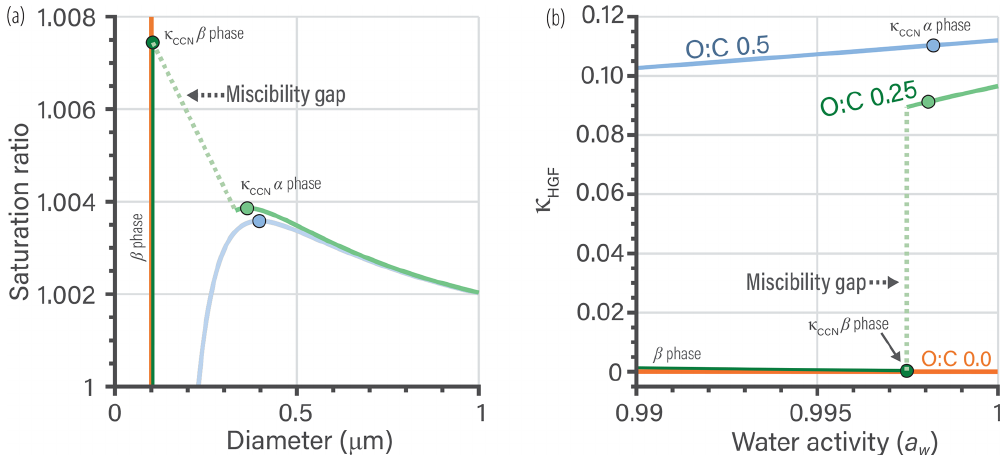
Figure 9. Three different organics with O : C of 0.5 (blue), 0.25 (green), and 0.0 (orange) with constant M org of 200gmol − 1 at T = 298 . 15K. (a) CCN growth curves for the three water–organic mixtures. (b) κ HGF versus water activity curves for the water–organic mixtures. The circles represent the extracted κ CCN values, based on the maximum in saturation ratio vs. particle diameter. The β -phase curve is shown in a darker shade for the organics with a miscibility gap (green and orange). The miscibility gap is denoted by a dotted line and is an undefined region in a thermodynamic equilibrium context (crossing it is a transient, nonequilibrium feature). The simulations assume a 100nm diameter-equivalent volume of organic matter at all points, while water uptake changes the overall particle diameter. The surface tension is approximated as a volume-weighted mean surface tension with pure water σ of 72mNm − 1 and pure organics of 30mNm − 1